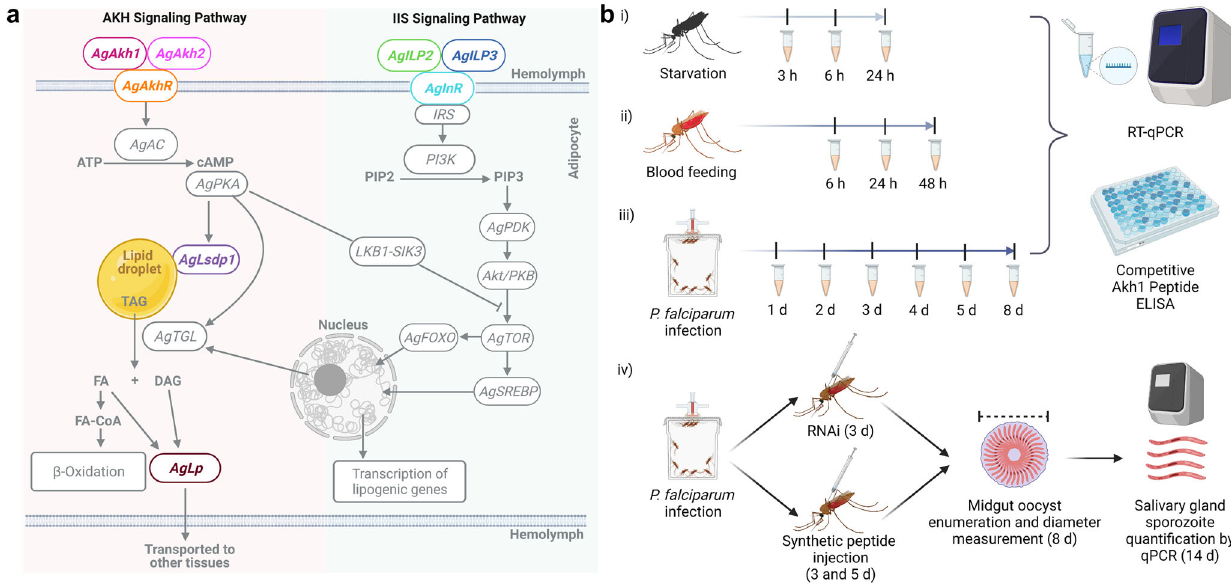
Fig. 1 Dissecting the adipokinetic hormone (AKH) signaling pathway in An. gambiae . a Simpli fi ed diagrammatic representation of the proposed AKH signaling and insulin/insulin-like growth factor signaling (IIS) pathway in in An. gambiae . Color-coded genes were targeted for transcript quanti fi cation using RT-qPCR. AgAkhR = An. gambiae adipokinetic hormone receptor, AgLsdp1 = An. gambiae Lipid storage droplets surface-binding protein 1, AgLp = An. gambiae lipophorin, AgILP = An. gambiae insulin-like peptide, AgInR = An. gambiae ILP receptor. Other ILPs in the IIS pathway that were quanti fi ed include AgILP1, AgILP4, AgILP5, AgILP6, and AgILP7 . b Schematic representation of study design depicting starvation (i), blood feeding (ii), P. falciparum infection (iii), and AKH perturbation assays (iv). The time points represent the hours of starvation, hours post bloodmeal and days postinfectious bloodmeal when mosquitoes were sampled for analysis. RT-qPCR = reverse transcription quantitative PCR, ELISA enzyme-linked immunosorbent assay. The fi gures were created with